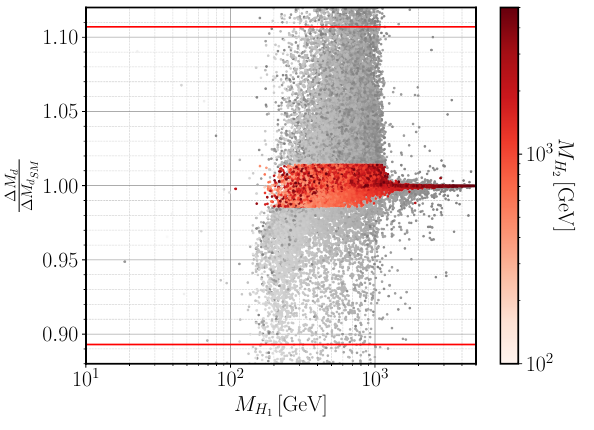
Figure 7 . B d mass difference as a function of heavier CP-even Higgs boson masses. The colour code is the same as in figure